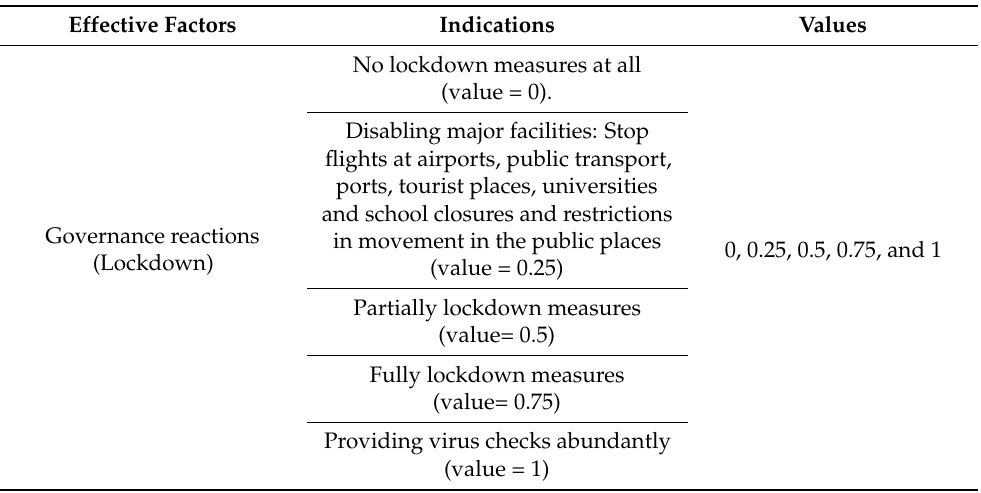
Table 1. The direct and indirect factors that are hypothesized to affect the spread level of COVID-19 in the selected